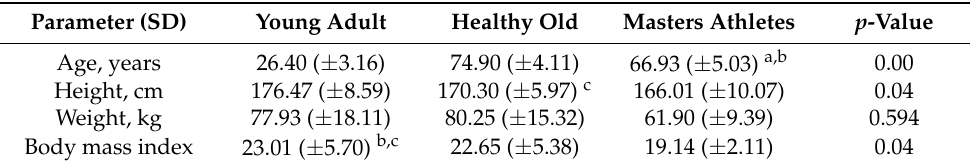
Table 1. Characteristics of participants divided by group.